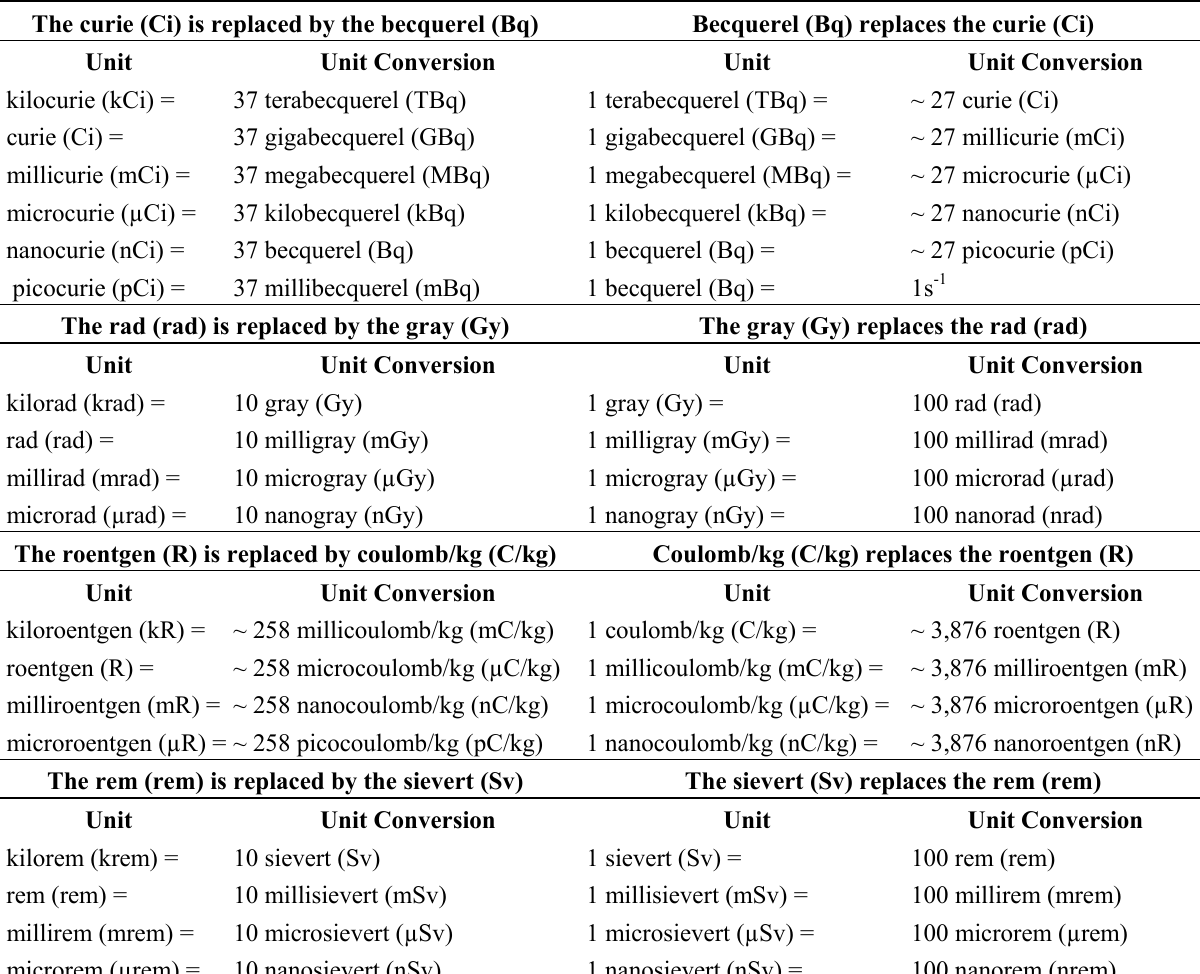
Table A3. Antidoting the confusion around radiation research. The curie (Ci) is replaced by the becquerel